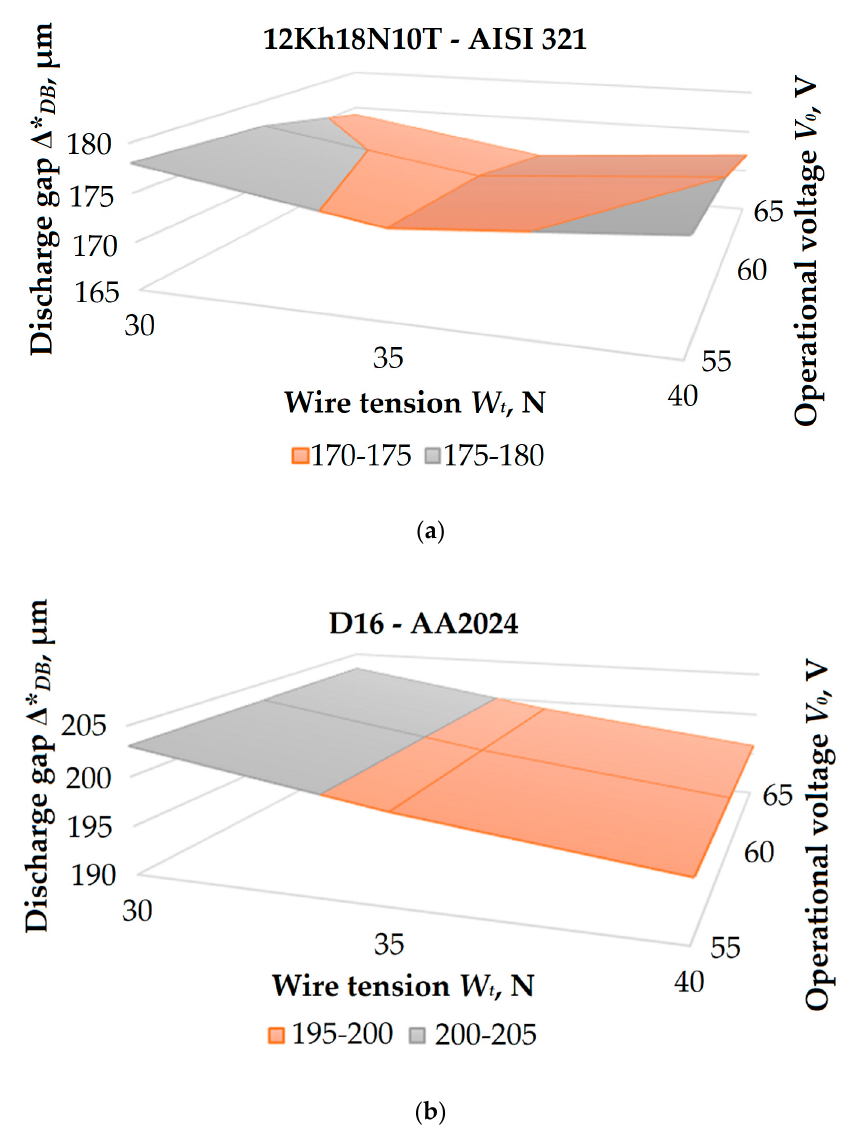
Figure 9. 3D graphs of the offsets Δ * DB dependencies on operational voltage V 0 and wire tension W t : ( a ) 12Kh18N10T (AISI 321) steel; ( b ) D16 (AA2024) alloy.